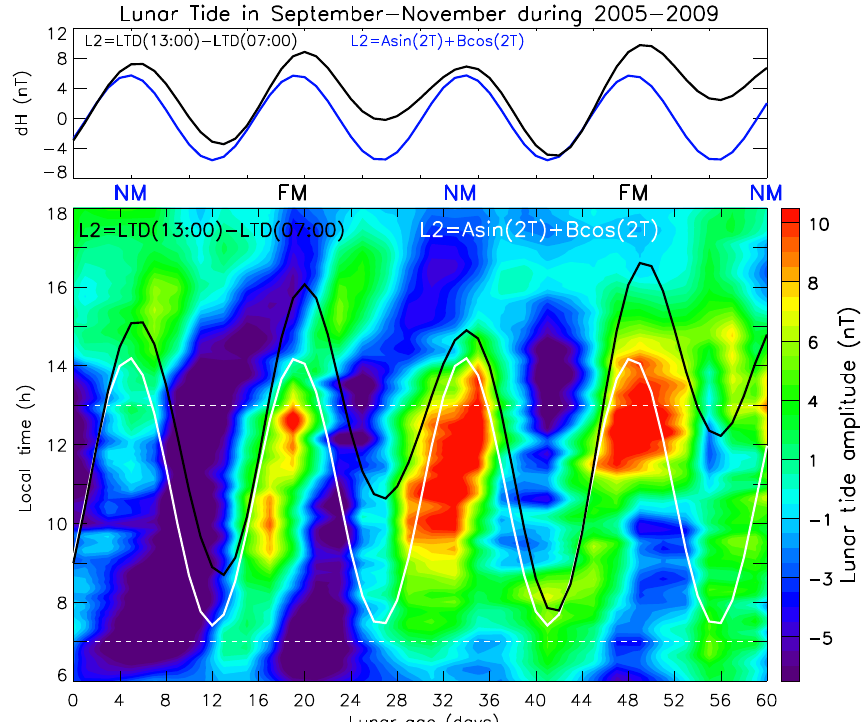
Figure 2. Bottom panel: lunar tides signature on the equatorial electrojet observed at Huancayo during September–November during 2005– 2009. Top panel: the standard component of the lunar tide variation (blue curve) and the difference between the residual extracted at two (13:00 and 07:00) fixed local times (black curve) plotted as a function of lunar age. The acronyms “FM” and “NM” refer to full and new Moon,